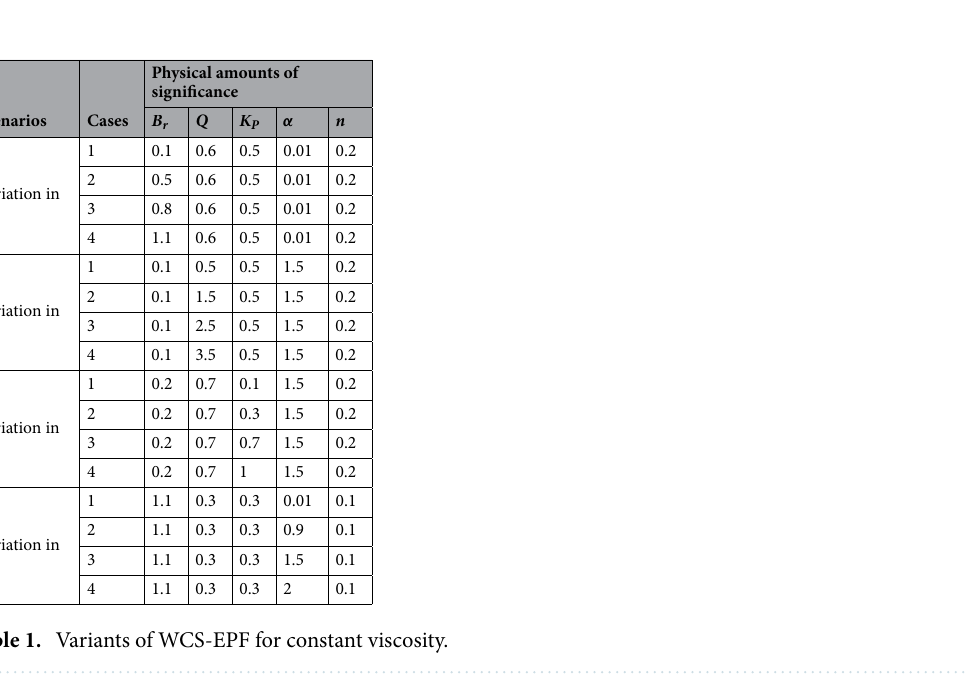
Figure 4. A single neural network model architecture.